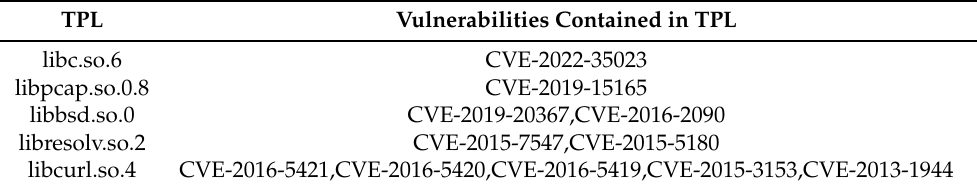
Table 5. Some vulnerable version of libraries and the vulnerabilities they contain. TPL Vulnerabilities Contained in TPL libc.so.6 CVE-2022-35023 libpcap.so.0.8